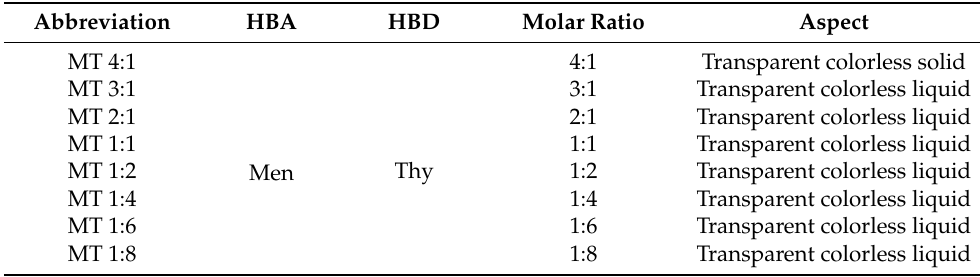
Table 2. Molar ratio of HBA and